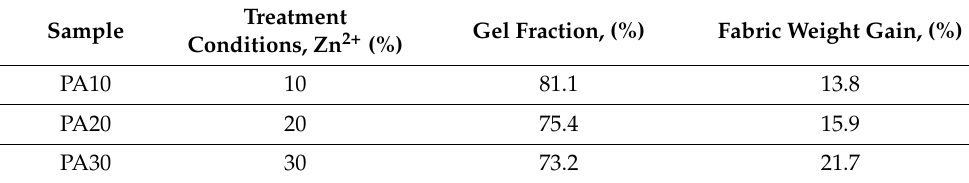
Table 1. Designation of the samples according to their Zn 2+